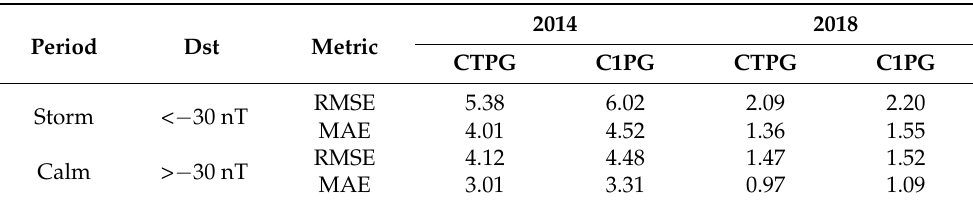
Table 5. RMSE and MAE values between the predicted TEC maps (CTPG and C1PG) and the IGS TEC maps (CODG) during a magnetic storm and a calm period in 2014 and 2018.